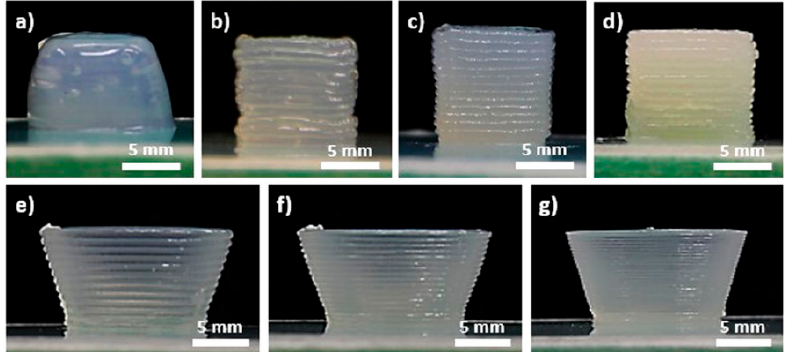
Figure 6. 1 cm 3 cubic cellulose nanocrystal (CNC) gel structures at ( a ) 11.8, ( b ) 15, ( c ) 20, and ( d ) 30 wt% are illustrated (nozzle tip size: 500 μ m). Bowl structures printed with a 20 wt% CNC gel, from nozzle tips of ( e ) 500, ( f ) 400, and ( g ) 200 μ m. Reprinted from [92], Sci. Rep. 2017.